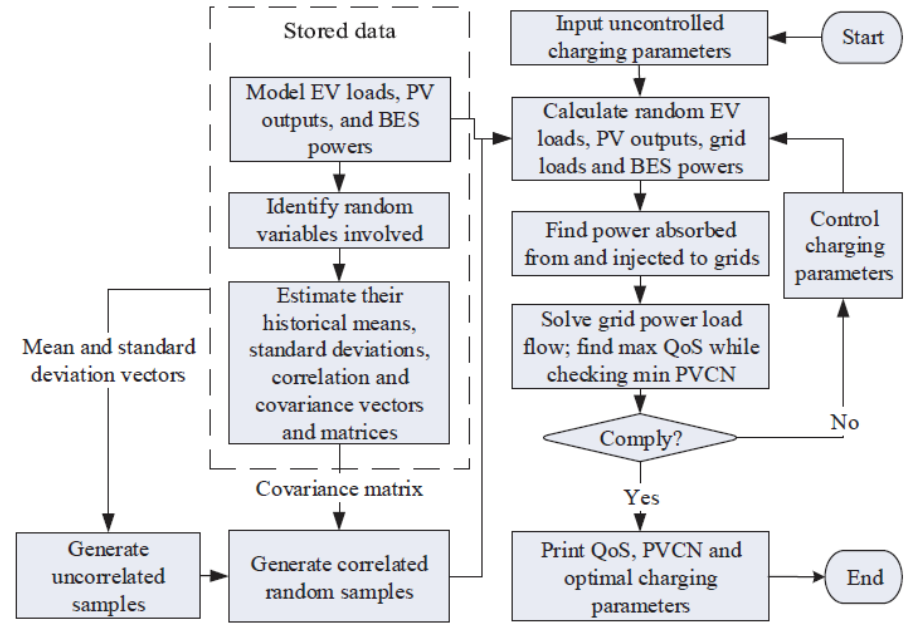
Figure 8. Flowchart for coordinated EV charging with PV and Grid loads.